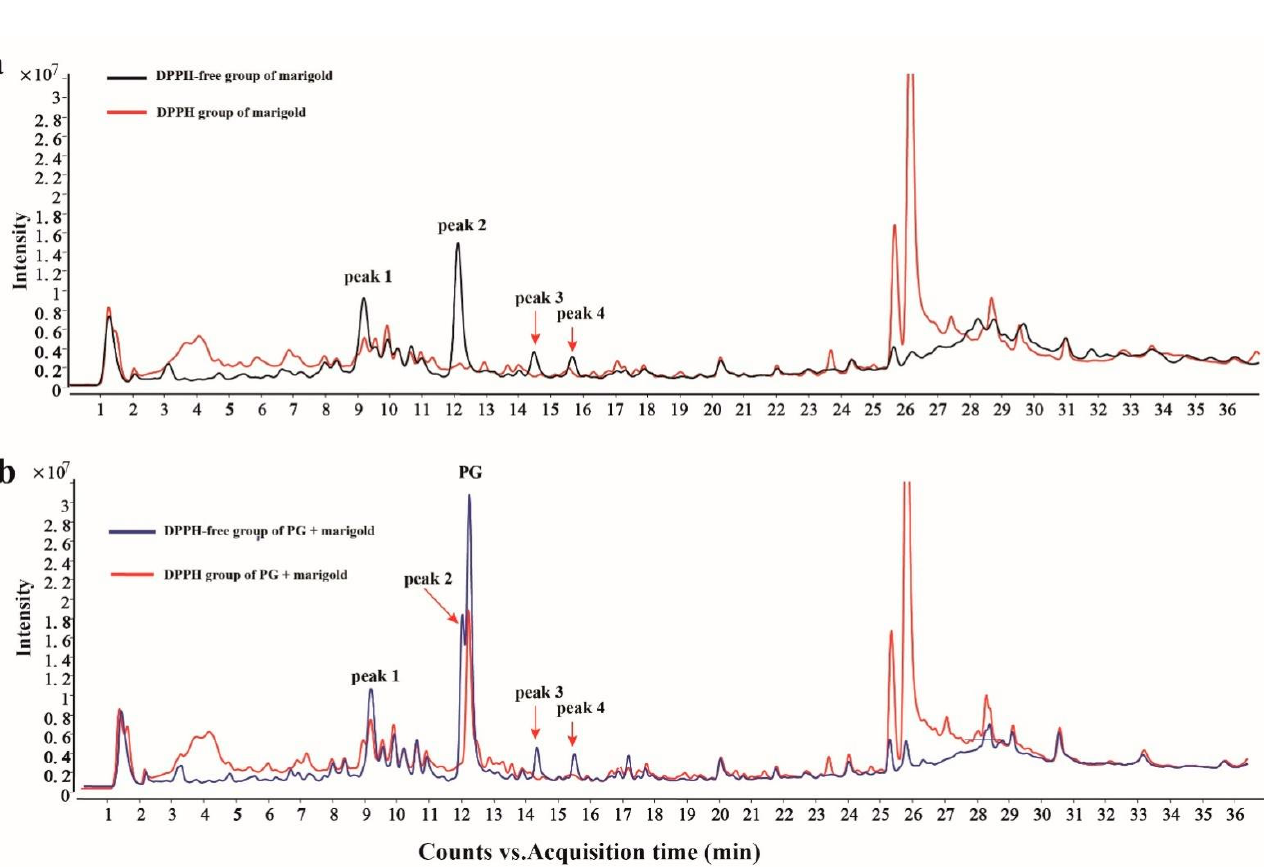
Figure 1. Chromatograms of the methanol extract of marigold before and after reaction with DPPH radicals ( a ); chromatograms of the methanol extract of marigold with PG chromatogram before and after reaction with DPPH radicals ( b ). Table 1. Relative PAs of peak 1 (quercetagetin-7- O -glucoside), peak 2 (quercetagetin), peak 3 (quer- cetin) and peak 4 (patuletin) after reaction with different concentrations of DPPH.